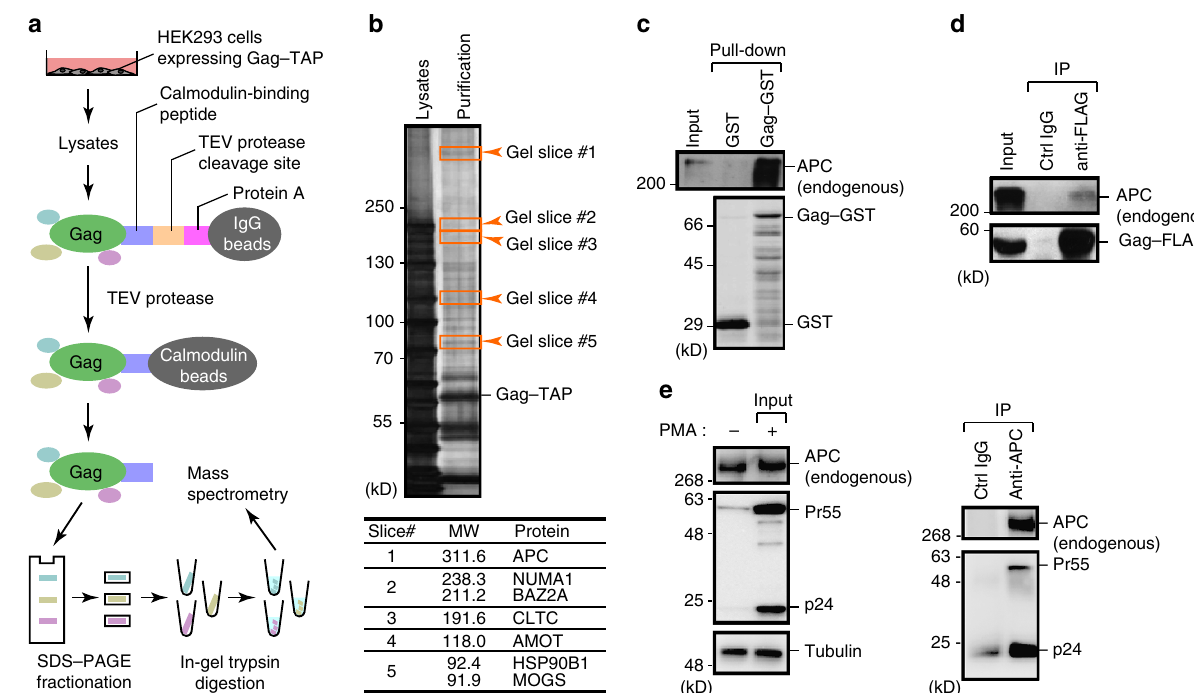
Figure 1 | Identification of the tumour suppressor APC as a HIV-1 Gag-binding protein. ( a , b ) HEK293 cells expressing Gag fused with TAP tag (IgG-TEV-calmodulin-binding motif) were lysed and subjected to TAP-tag-based purification. ( a ) Proteins bound to Gag–TAP were isolated and detected by SDS–PAGE and silver staining. ( b , top) Peptides derived from the excised gel slices (arrowheads) were analysed by matrix-assisted laser desorption ionization–time of flight (MALDI-TOF) mass spectrometry ( b , bottom). Detailed information on the proteins identified by mass spectrometry is provided in Supplementary Table 1. MW, molecular weight. ( c ) Extracts of HEK293 cells were subjected to GST pull-down analysis using either GST or Gag–GST followed by immunoblotting with anti-APC antibody. ( d ) HEK293 cells expressing Gag–FLAG were lysed and subjected to immunoprecipitation with anti- FLAG antibody followed by immunoblotting with anti-APC antibody. ( e ) ACH-2 cells stimulated with phorbol 12-myristate 13-acetate (PMA) were lysed and subjected to immunoprecipitation with anti-APC antibody followed by immunoblotting with anti-p24 antibody. Full images for all immunoblots are provided in Supplementary Fig.